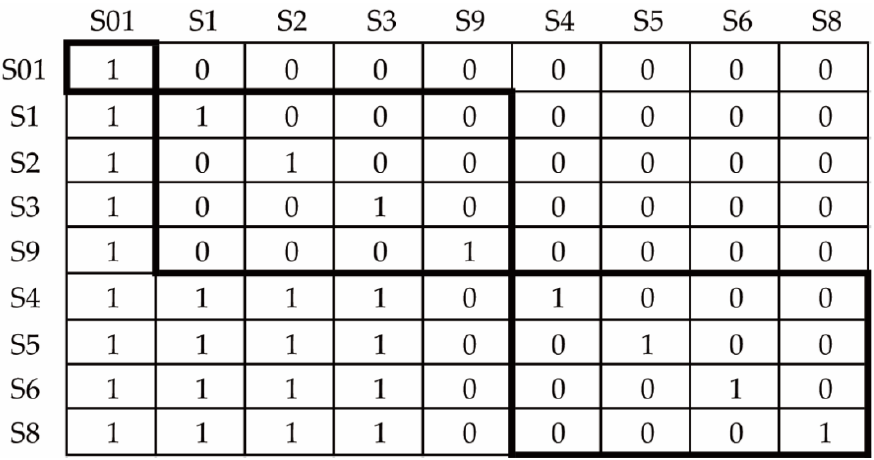
Figure 4. Relationship between factors affecting response to the planting of specialty orchard fruits.